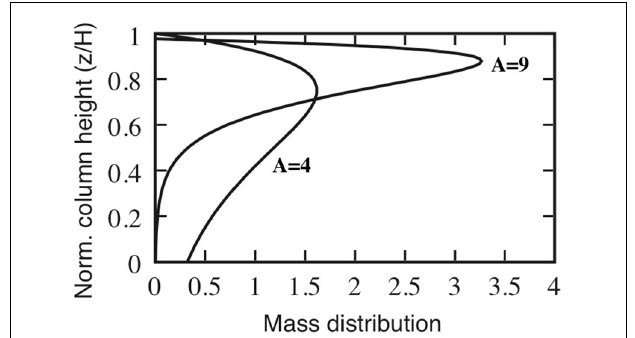
FIGURE 1 | Mass distribution inside the eruption column in accordance with Suzuki’s (1983) parameterization: s ( z ) = (cid:4) (cid:2) (cid:3)(cid:5) exp A z / H − 1 , where s ( z ) is the normalized mass distribution, H is the column height, A is a dimensionless shape parameter, and z is the vertical coordinate. Relative column height is reported on the y -axis and mass distribution on the x